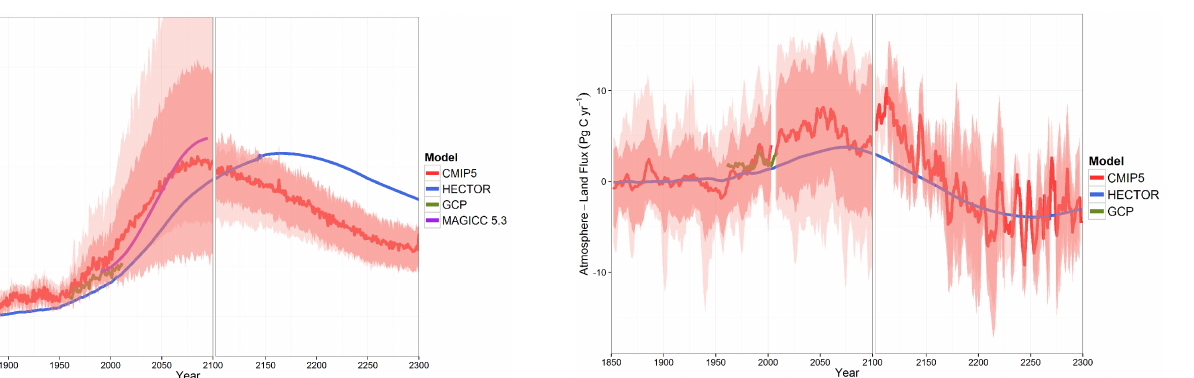
Figure 9. Global air–sea fluxes of carbon under RCP 8.5; Hector (blue); MAGICC5.3 (purple, note that this is not the current ver- sion of MAGICC); CMIP5 median, standard deviation, and model range (pink, n = 9 (1850–2100) and n = 4 (2101–2300)); and ob- servations from GCP (green) (Le Quéré et al., 2013). The break in the graph at 2100 signifies a change in the number of models that ran the RCP 8.5 extension.